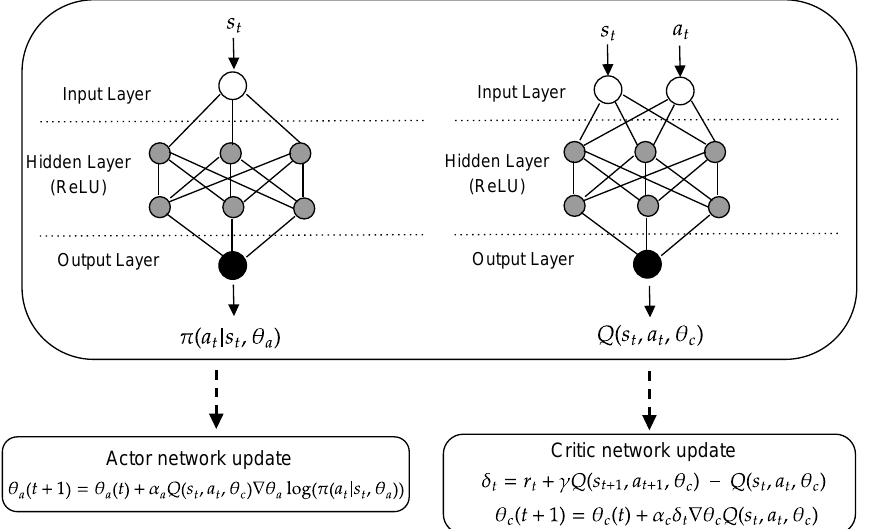
Figure 3. Diagram describing the update of the actor and critic parameterized by a deep neural